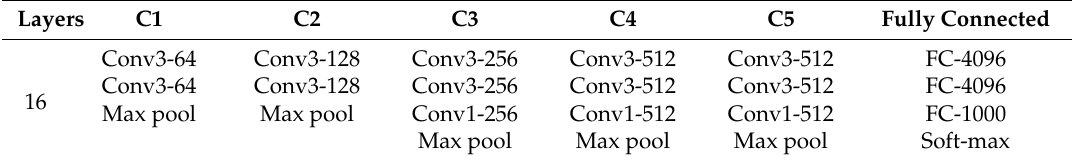
Table 1. VGG16 network configuration.